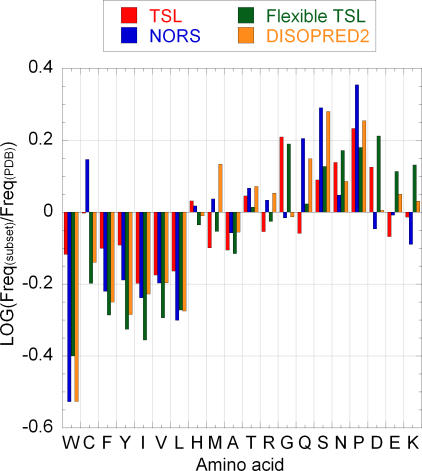
Regular, Flexible, and Predicted-To-Be Unstructured Loops DifferedWe compared the amino acid compositions between four different subsets representing four types of “loops” (nonhelix/nonstrand): loops from regular, well-ordered structures; i.e., from proteins without natively unstructured regions (states T, S, L from the Dictionary of Secondary Structure of Proteins; in blue); unstructured loops as predicted by NORSnet (in green); “flexible loops” from regular structures (TSL states with normalized B-factors ≥1 [82]; in red); and unstructured regions as predicted by DISOPRED2 (in orange). The sign of the bar corresponds to overrepresentation (positive) or underrepresentation (negative) of amino acids in a subset with respect to the PDB. The NORS and DISOPRED2 residue subsets were taken from the worm genome (from the IntAct database [67]) and were predicted to be unstructured by NORSnet and DISOPRED2. Flexible loops were enriched in amino acids with net charges such as lysine and glutamate (as described before [16,39]). Predicted unstructured regions by NORSnet, however, differed in their composition from regular loops, flexible loops, and from any type of disorder that has been described previously (unpublished data) [39,44]. Cysteines were not overabundant in the unstructured regions predicted by DISOPRED2. Overall, these data suggested that NORSnet captured something other than just “loop” and other than what is captured by methods such as DISOPRED2.